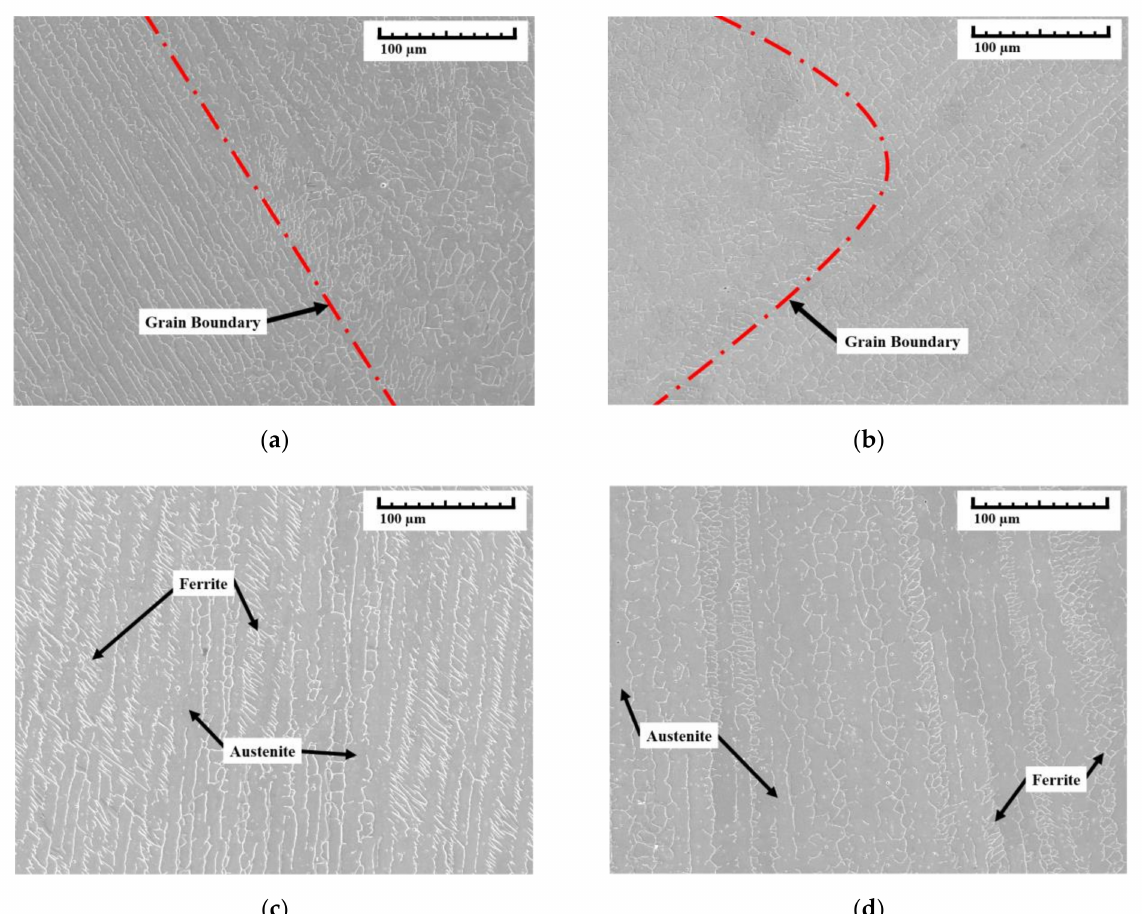
Figure 13. Microstructure of the WAAM-deposited beads studied using SEM: ( a ) section view A-A, ( b ) section view D-D, ( c ) section view B-B, and ( d ) section view